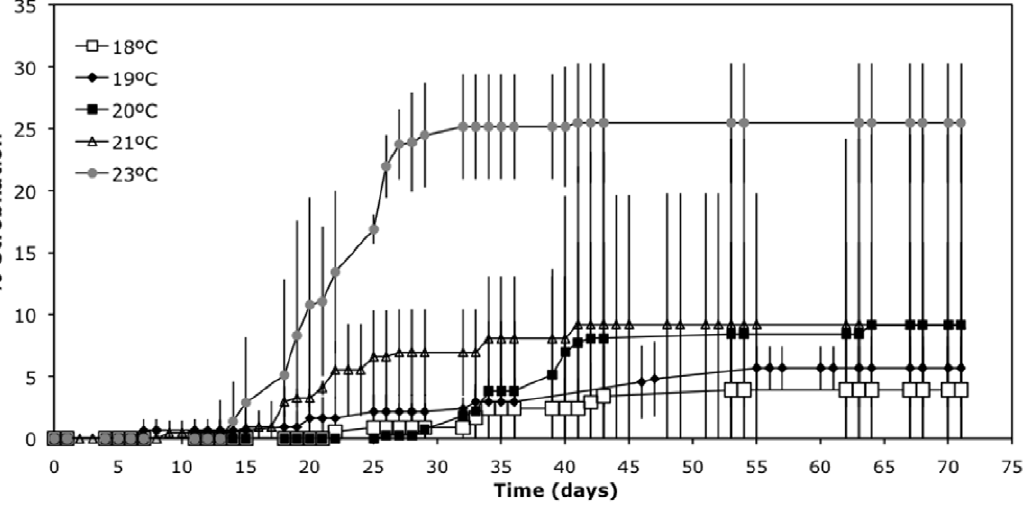
Figure 6. Triggering of strobilation by an increase in temperature (Experiment G). Cumulative percentage of polyp strobilation during a change of temperature from 17.5 u C to 18, 19, 20, 21 and 23 u C. Previously polyps were at 17.5 u C for 5 months. The x-axis is the time (days) after the increment of temperature. Error bars are the standard deviation of the three replicates’.